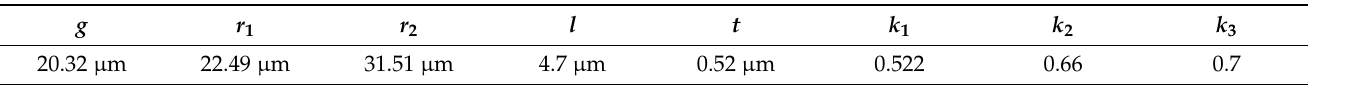
Figure 10. ( a ) Change in D with k 1 ; ( b ) Change in D with k 2 ; ( c ) Change in D with k 3 ; ( d ) Change in DGD with k 1 ; ( e ) Change in DGD with k 2 ; ( f ) Change in DGD with k 3 . Table 2. Parameter settings when reaching the minimum of the maximum dispersion coefficient and differential group